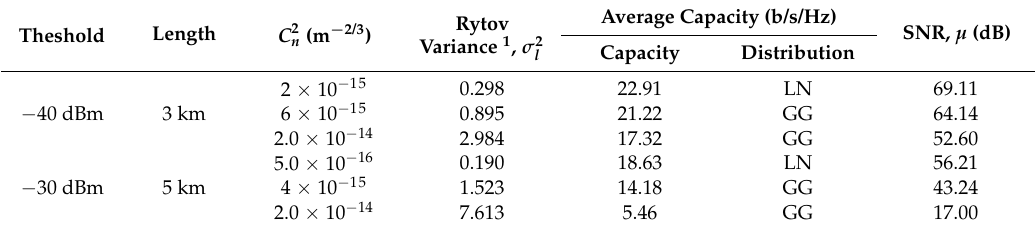
Table 3. Average channel capacity for an FSO link with the parameters of Table